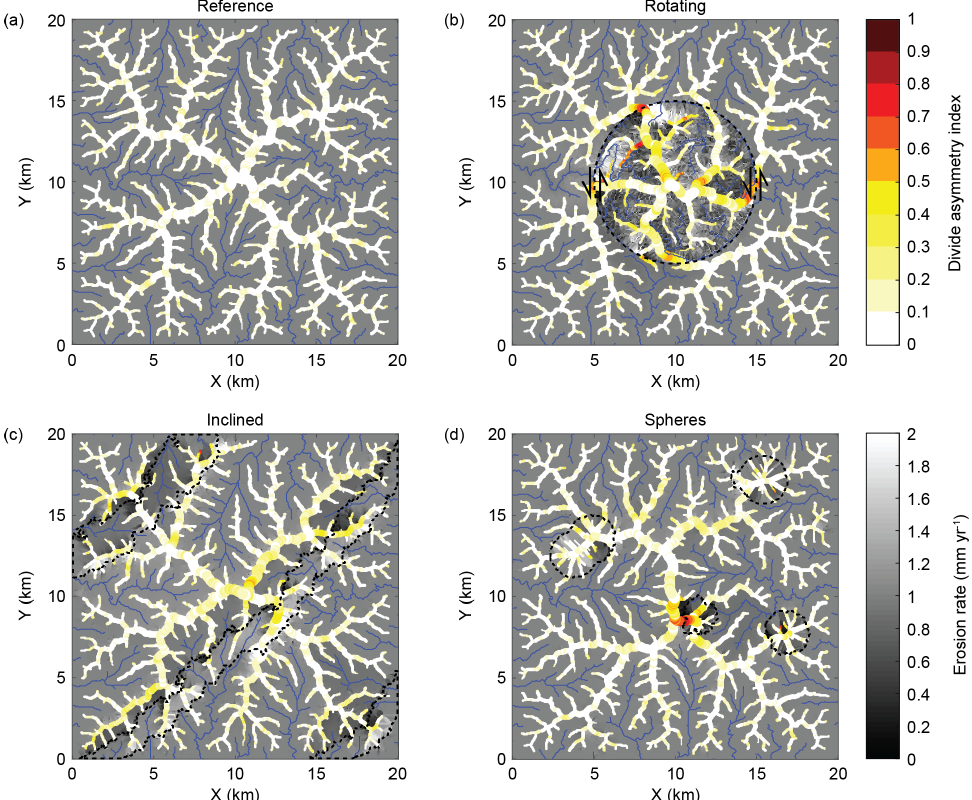
Figure 5. Erosion rates and divide asymmetry index (DAI) at the end of the landscape evolution experiments: (a) Reference, (b) Rotating, (c) Inclined, and (d) Spheres. Black stippled lines show strike-slip fault in panel (b) and regions with reduced erodibility in panels (c) and (d) .